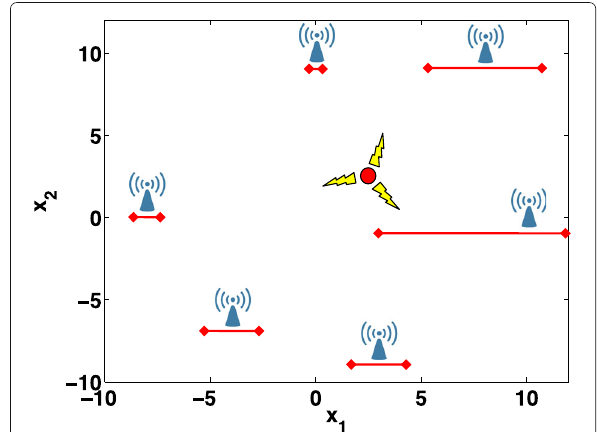
Fig. 6 Location of the sensors and the target for the example in Section